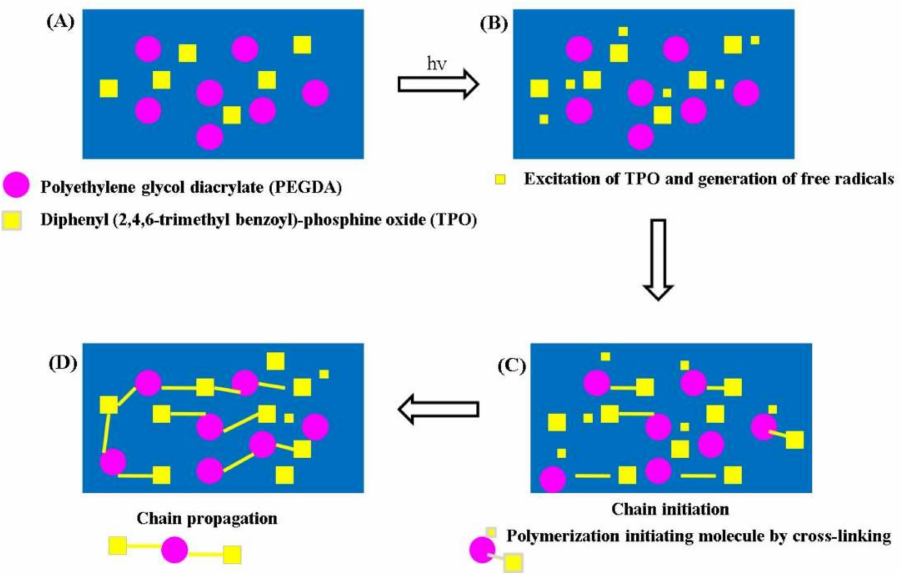
Figure 2. Photo polymerization of polyethylene glycol diacrylate (PEGDA) using diphenyl (2,4,6- trimethyl benzoyl)-phosphine oxide (TPO) as photo initiator ( A ) Monomer and photo initiator ( B ) Generation of free radicals ( C ) Polymerization initiation molecule ( D ) Cross-linking—chain prop-